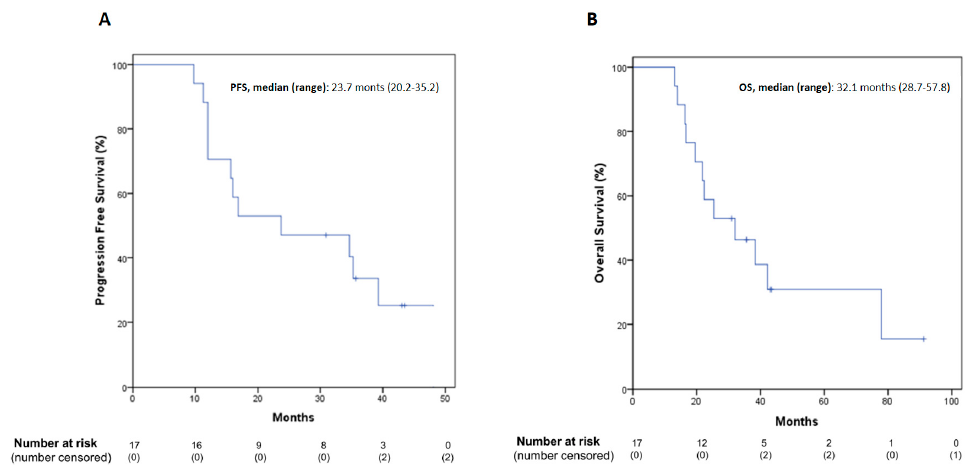
Figure 2. PFS ( A ) and OS ( B ) Kaplan–Meier curves in the total population. PFS: progression-free survival; OS: overall survival.